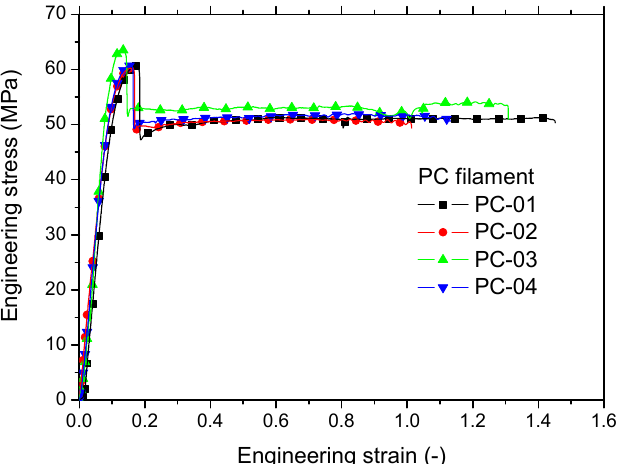
Figure 5. Typical stress–strain curves of as ‐ received four replicates of PC filament.